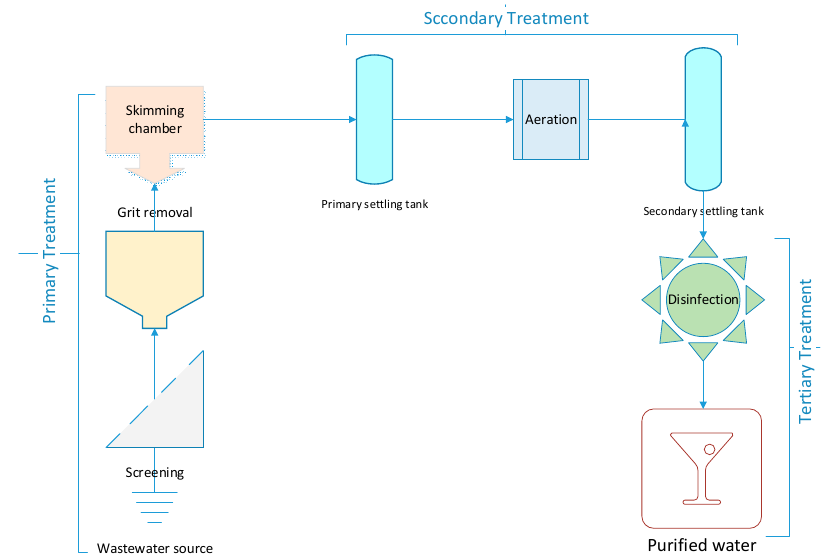
Figure 1. Depicts a schematic representation of industrial and municipal wastewater sources